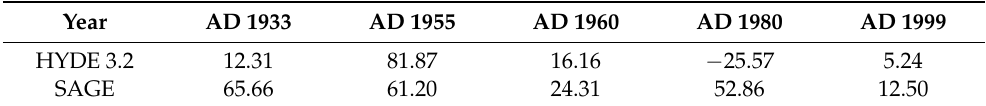
Table 2. The relative difference rates of the total cropland area in Xinjiang province from AD 1933 to 1999 between HYDE 3.2, SAGE, and the Ge datasets (unit: %).